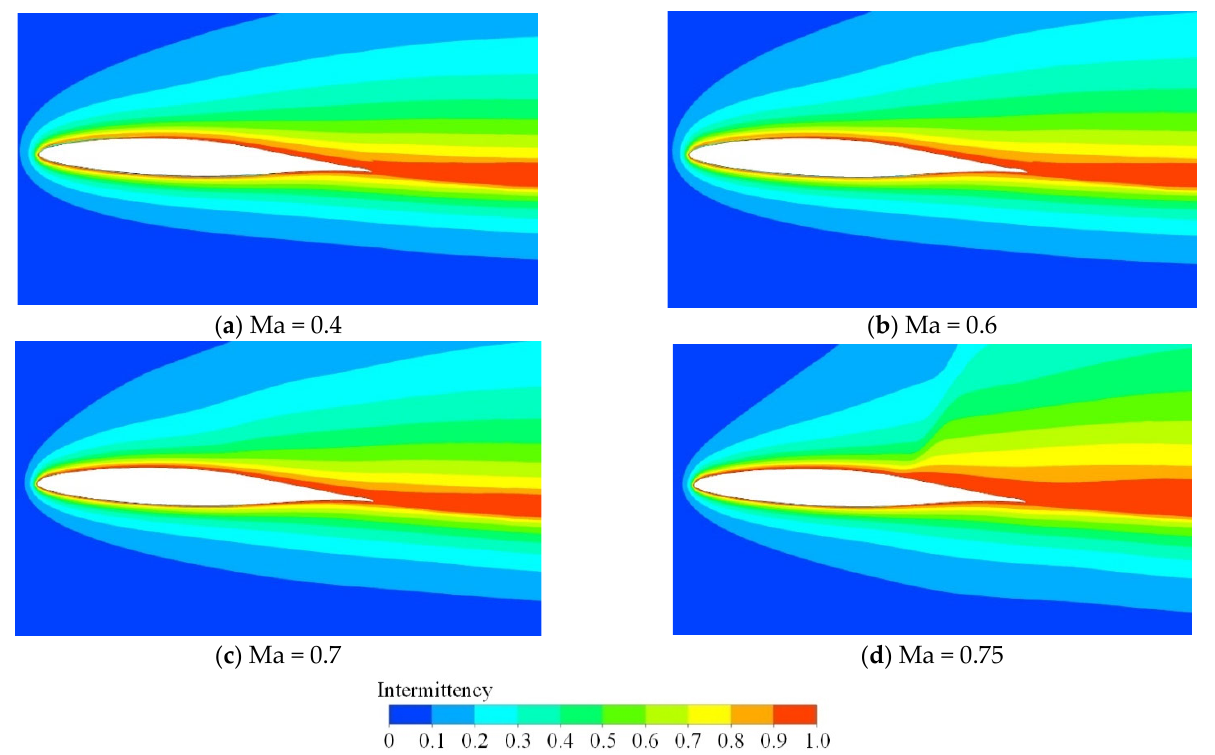
Figure 19. Influence of Mach number on distribution of intermittency ( ε = 0.5% , T w = 293 K , α = 3°). The influence of Mach number on the streamline distribution of the intermittency under negative and positive angles of attack is illustrated in Figures 20 and 21,